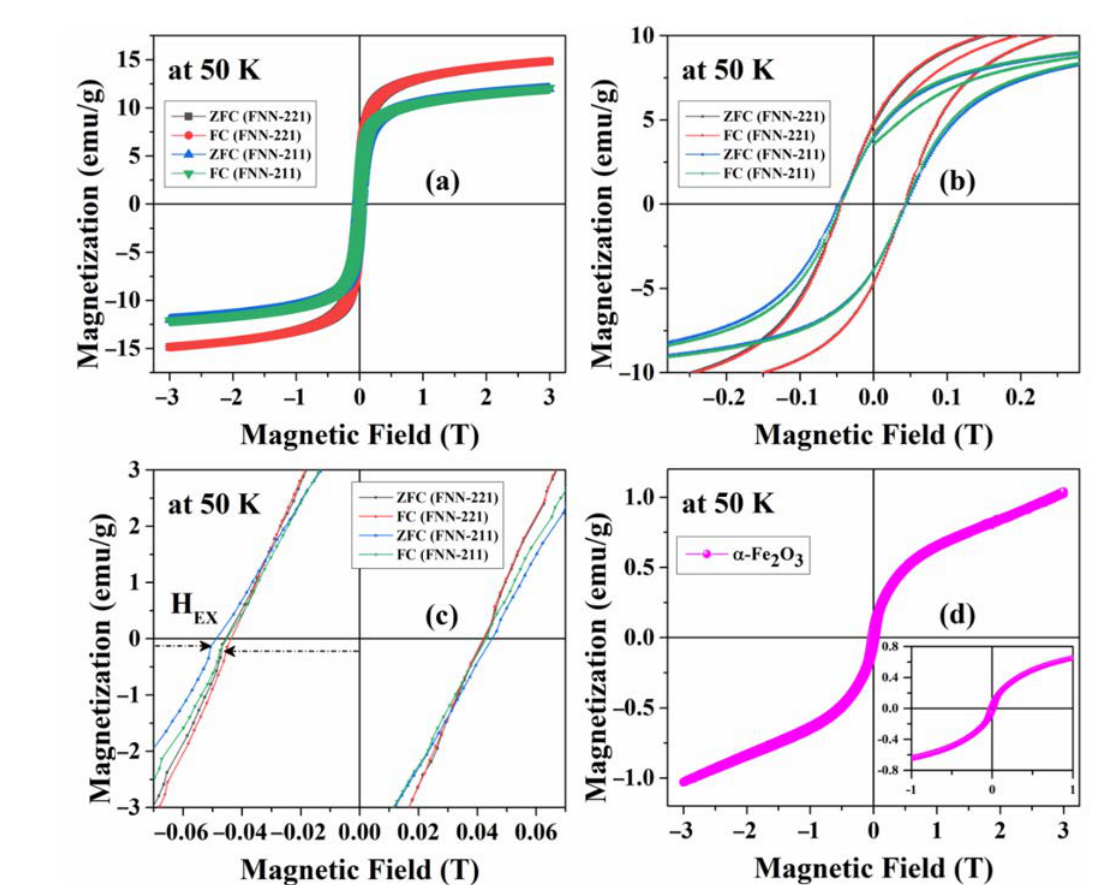
Figure 7. ( a ) Low temperature (50 K) FC-ZFC magnetization behavior of FNN-221 and FNN-211 samples under a variable applied field. ( b ) Local magnification of the MH curve indicating the difference between the ZFC and FC magnetization of both samples. ( c ) Shift in the hysteresis loop of FNN-211 sample in comparison to FNN-221 sample, signifying the exchange bias field ( H ex ). ( d ) Comparison of Low temperature (50 K) magnetization for α -Fe 2 O 3